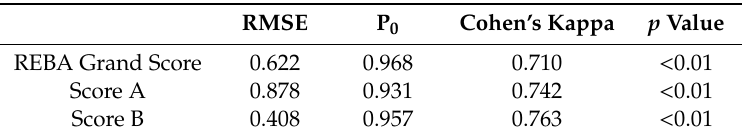
Table 5. Comparing linear weighted Cohen’s kappa, P 0 , and RMSE, consistency between Quick Capture and expert evaluation was